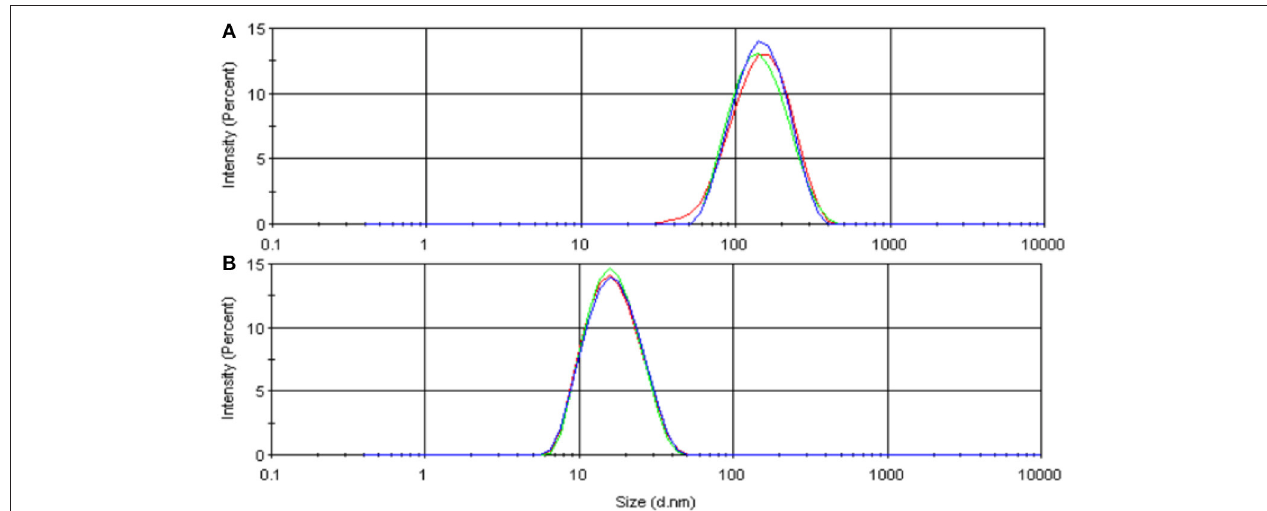
FIGURE 3 | Size distribution measured by DLS: (A) FNP; (B) CNP. The Y axis is light scattering intensity.